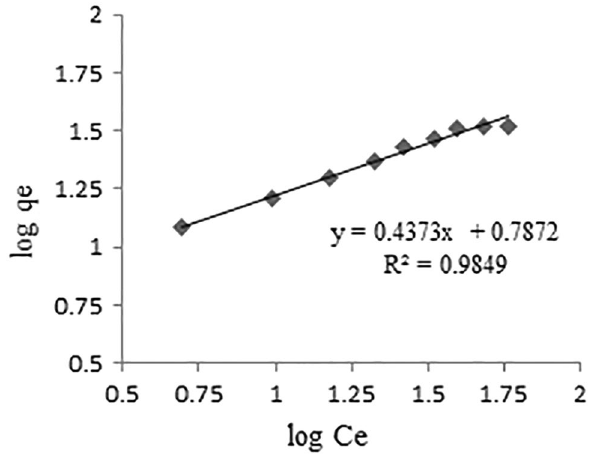
Fig. 4 Freundlich plots for sorption (pH 6, time 30 min,